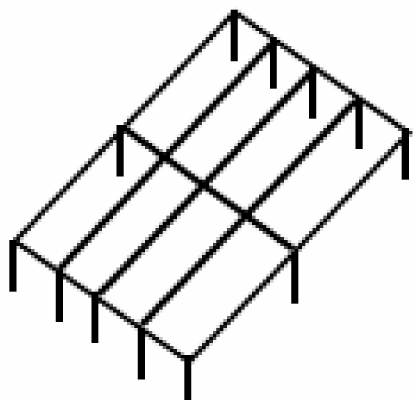
Figure 3. A mesh 20 m × 30 m of remote earth for impulse tests on single-rod, 2-rod and 3-rod electrodes.